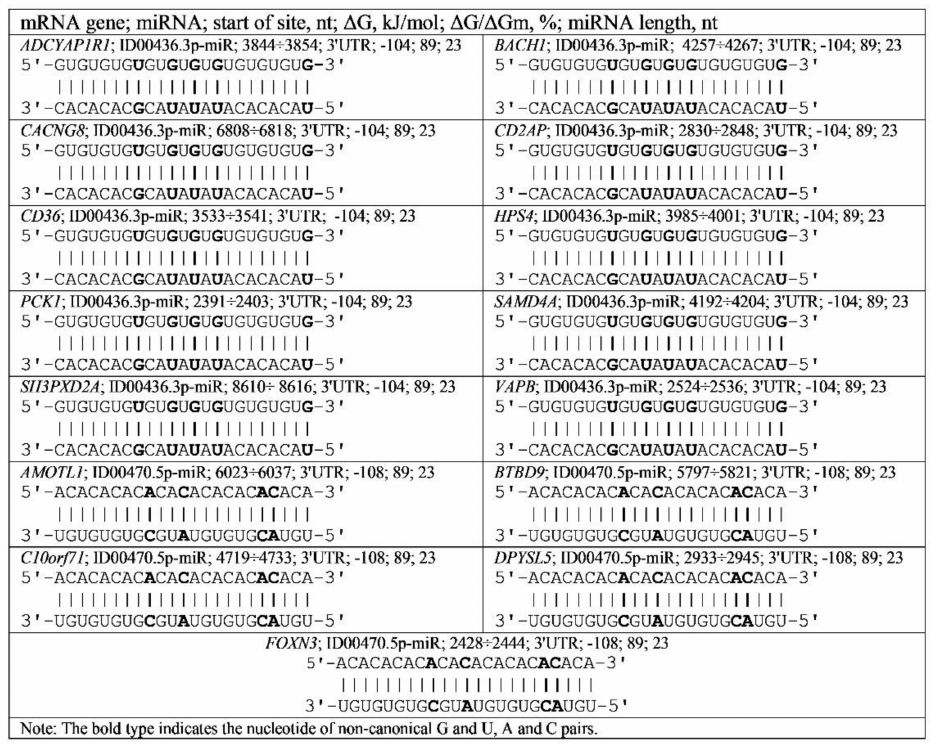
Figure 2. Schemes of ID00436.3p-miR and ID00470.5p-miR binding with mRNA of genes having GU and AC dinucleotide repeats in the 3 (cid:48)